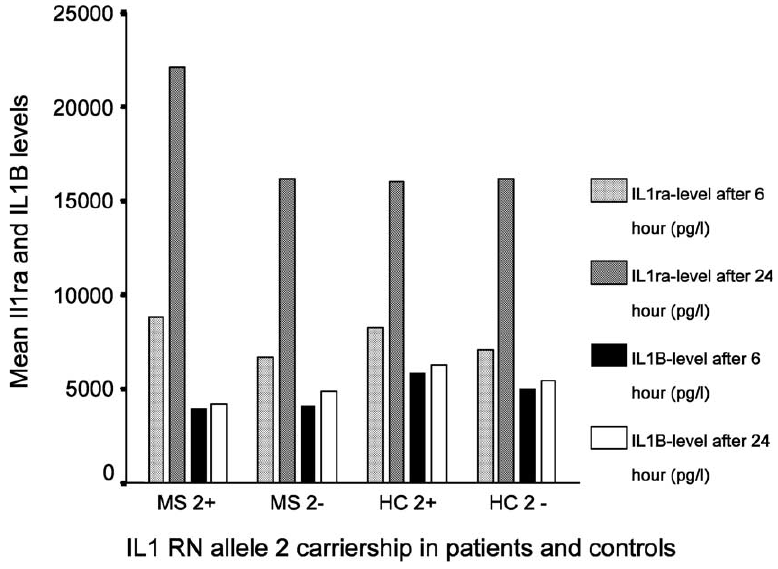
FIG. 2. Mean IL-1ra and IL-1 b levels after 6 and 24 h in MS patients and controls (HC) after stratification for IL-1RN allele 2 carriership. 2 (cid:2) / , IL-1RNallele 2 (cid:2) / /IL-1 b allele 2 (cid:3) / ; 2 (cid:3) / , IL-1RNallele 2 (cid:3) / /IL-1 b allele 2 (cid:3) /